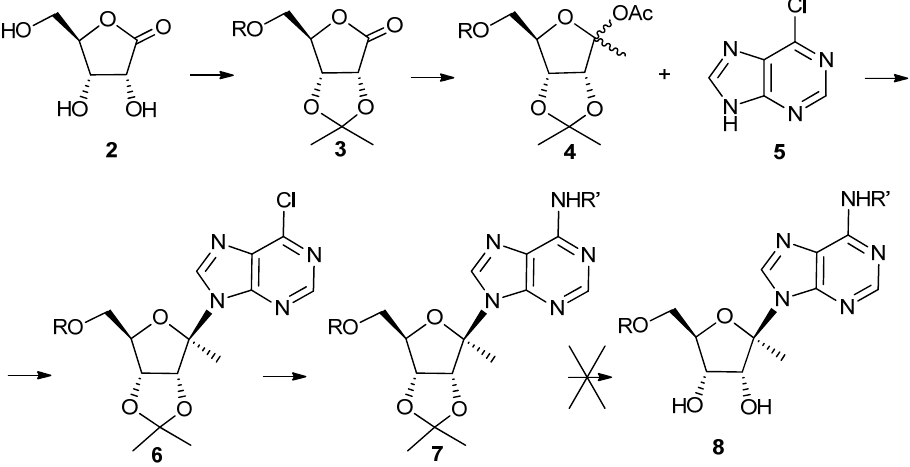
Scheme 1. Planned pathway to achieve the 1’ C -substituted nucleosides analogue 8 .